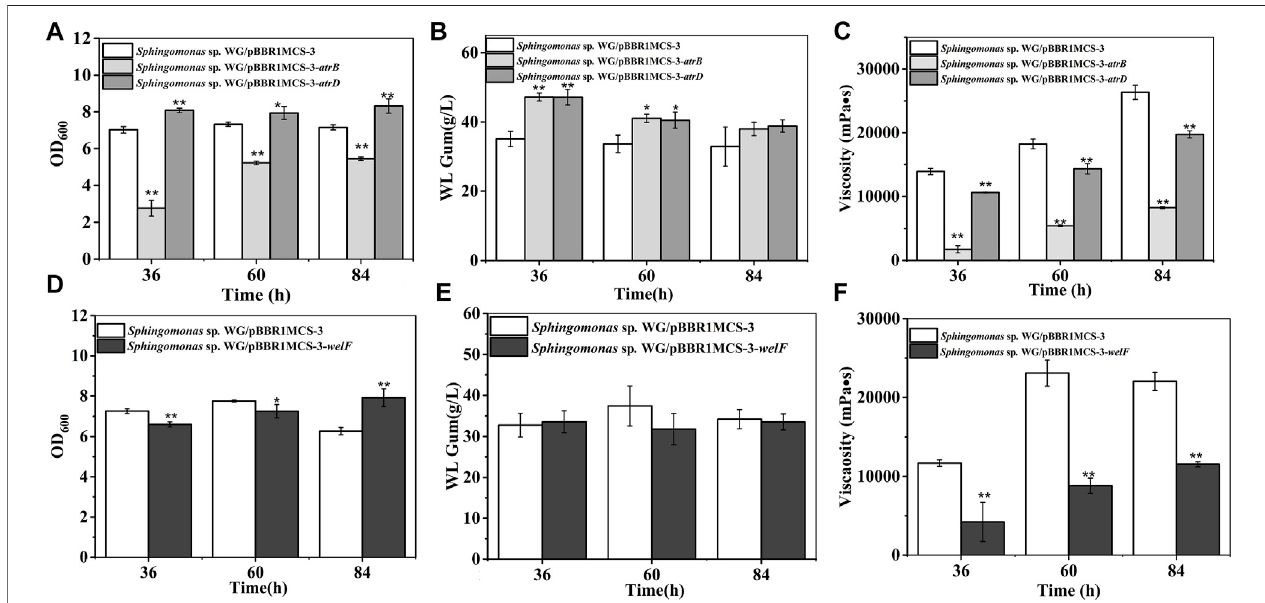
FIGURE 5 | Fermentation results of over-expression strains containing atrB , atrD, or welF . (A) Comparison of biomass of Sphingomonas sp. WG/pBBR1MCS-3- atrB and Sphingomonas sp. WG/pBBR1MCS-3- atrD . (B) Comparison of WL gum production of Sphingomonas sp. WG/pBBR1MCS-3- atrB and Sphingomonas sp. WG/pBBR1MCS-3- atrD . (C) Comparison of fermentation broth viscosity of Sphingomonas sp. WG/pBBR1MCS-3- atrB and Sphingomonas sp. WG/pBBR1MCS-3- atrD . (D) Biomassof Sphingomonas sp. WG/pBBR1MCS-3- welF . (E) WLgumproduction of Sphingomonas sp.WG/pBBR1MCS-3- welF . (F) Fermentation broth viscosity of Sphingomonas sp. WG/pBBR1MCS-3- welF . The fermentation was preformed in 250 ml shaking fl asks containing 50 ml fermentation medium (67 g/L Glc, 3.4 g/Lyeastextract,0.1